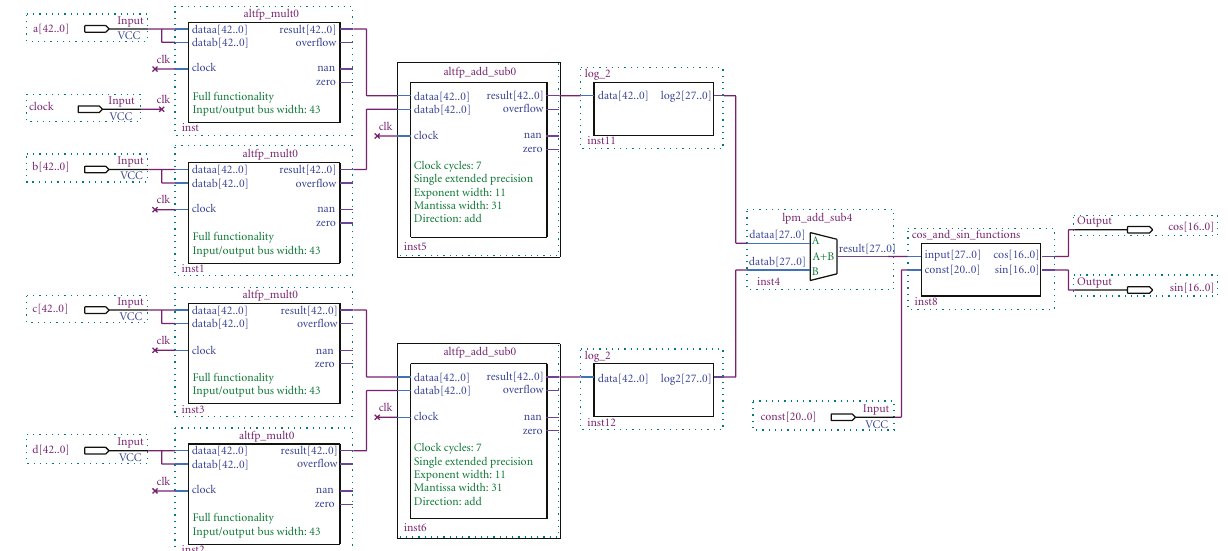
Figure 17: FPGA realization of concentration